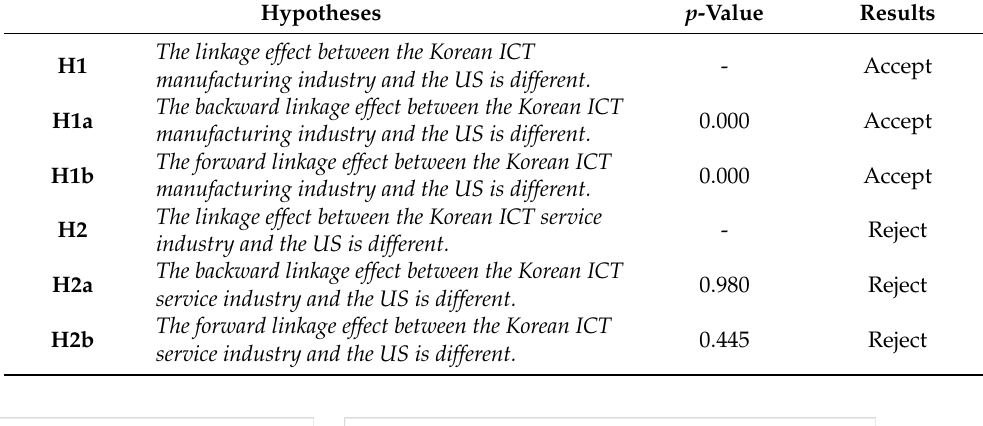
Table 10. Results of hypothesis testing.